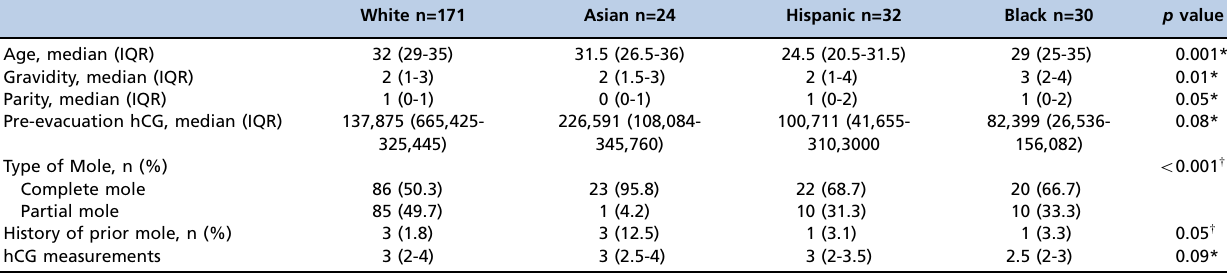
Table S3 - Characteristics of women with hydatidiform molar pregnancies by race/ethnicity. White n=171 Asian n=24